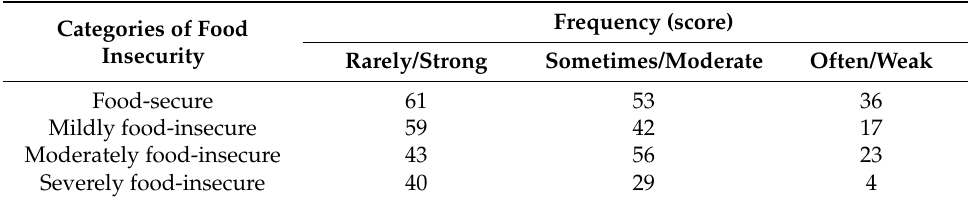
Table 5. Smallholder livestock farmer households’ resilience levels to food insecurity in the Northern Cape Province of South